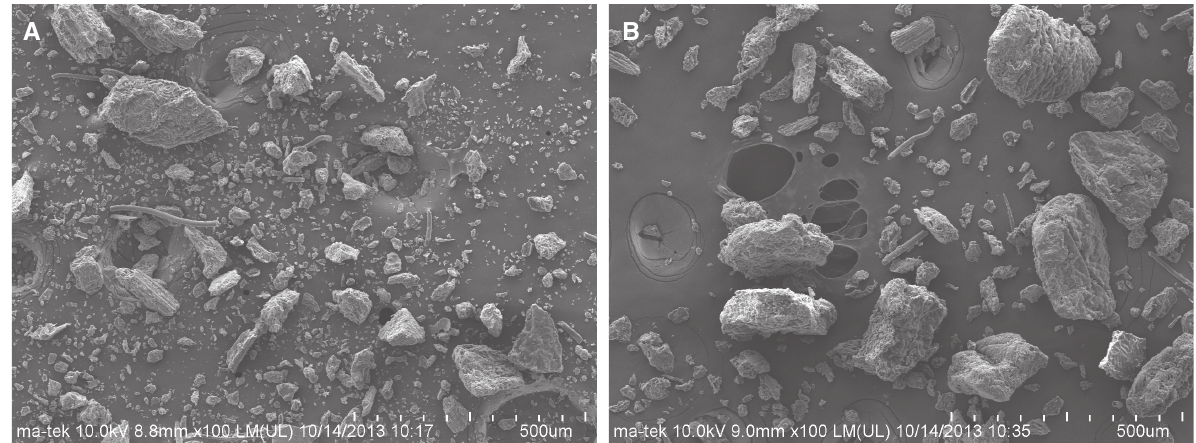
Figure 2 Scanning electron microscopy (SEM) images of ‘green’ (A) TEA-Fe and (B) CAF-Fe catalysts.